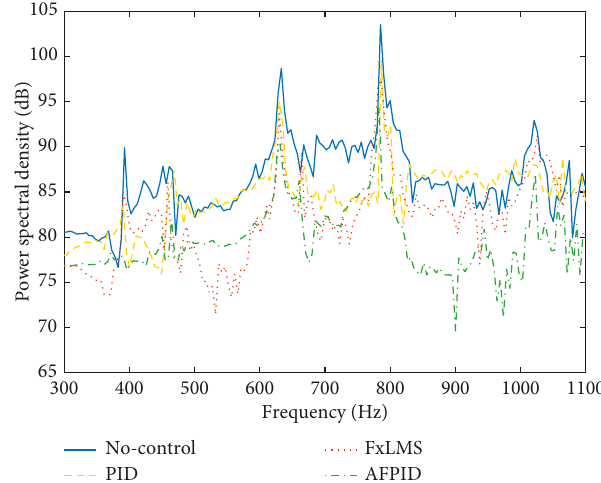
Figure 15: Frequency domain diagram of active gearbox vibration control.